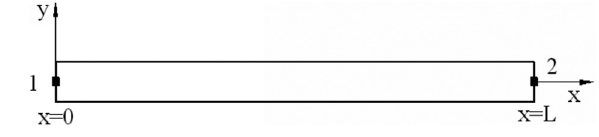
Fig. 2. Uniform Euler-Bernoulli beam with free end